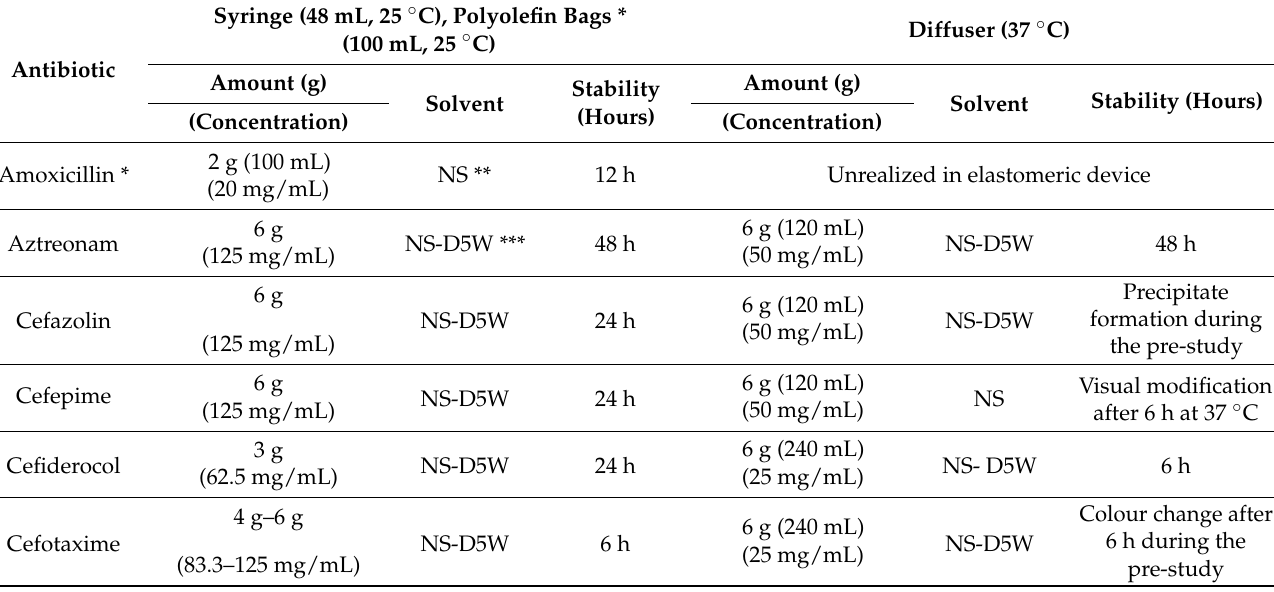
Table 7. Stability data for antibiotics in syringes, polyolefin bags *, or elastomeric devices. Syringe (48 mL, 25 ◦ C), Polyolefin Bags Antibiotic